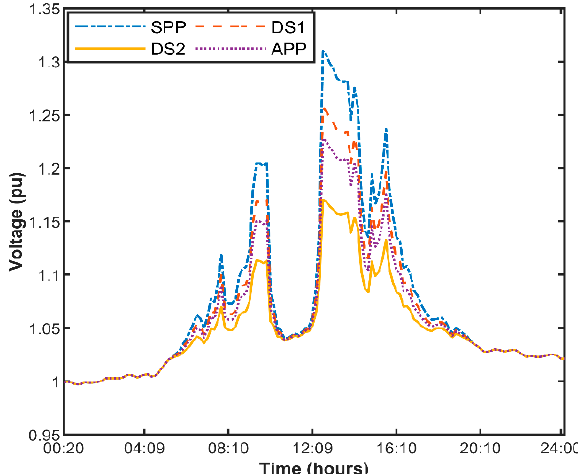
Figure 12. Winter day voltage profile at critical bus R15: 74% PV penetration.